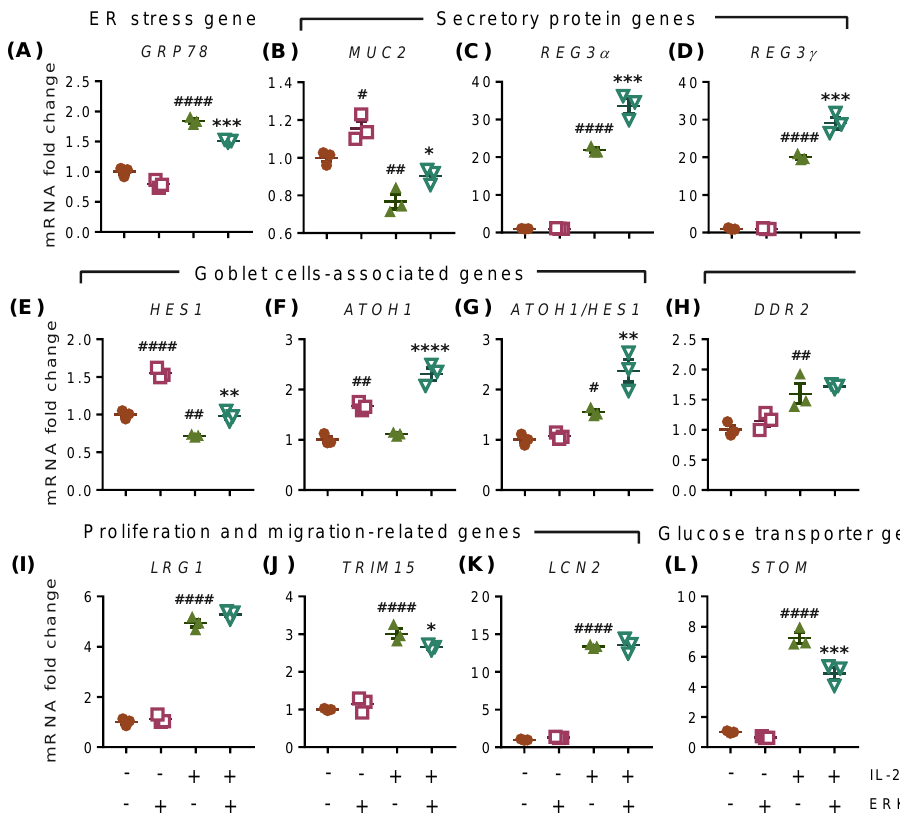
Figure 7. IL-22-mediated transcriptional changes in intestinal LS174T cells. Cells were pre-treated with 10 μM of ERK1/2 inhibitor for 1 h before treatment with IL-22 (50 ng/mL) for 12 h. mRNA expression of ( A ) ER stress marker GRP78, ( B ) mucin gene MUC2, antimicrobial peptides ( C ) REG3α and ( D ) REG3γ, ( E ) goblet cells-associated factor HES1, ( F ) cell differentiation marker ATOH1, ( G ) ATOH1 and HES1 ratio, cell proliferation-associated genes ( H ) DDR2, ( I ) LRG1, ( J ) TRIM15, and ( K ) LCN2, and ( L ) glucose transporter STOM. Data are presented as mean ± SEM with individual cultures ( n = 3 from one experiment). # p < 0.05; ## p < 0.01; #### p < 0.0001 compared with control and * p < 0.05; ** p < 0.01; *** p < 0.001 compared with IL-22 (one-way ANOVA followed by Dunnett’s post hoc test). 2.7. IL-22-Induced Effects Are Mediated through ERK1/2-Dependent and -Independent Transcriptional Modifications Inhibition of the ERK1/2 signaling pathway partially decreased IL-22-induced GRP78 expression (Figure 7A). ERK1/2 inhibitor alone significantly increased expression of MUC2 (Figure 7B), HES1 (Figure 7E), and ATOH1 (Figure 7F), which is suggestive of a more dominant secretory cell phenotype when the ERK1/2 pathway was inhibited. Although ERK1/2 inhibition had no effect on basal expression of the secretory antimicrobial peptides REG3α and REG3γ , IL-22-driven expression of these genes was boosted by ERK1/2 inhibition in the LS174T cells (Figure 7C,D) and primary mIECs (Supplementary Figure S4A,B). We did not observe any changes in the expression of sXBP1 , NOS2 , and AGR2 with ERK1/2 inhibitor (Supplementary Figure S4G–I). We found that IL-22 promoted the expression of cell proliferation and migration-associated genes including DDR2 (Figure 7H), LRG1 (Figure 7I), TRIM15 (Figure 7J), and LCN2 (Figure 7K) and glucose transporter STOM (Figure 7L). Inhibition of the ERK1/2 pathway only reversed the expression of TRIM15 (Figure